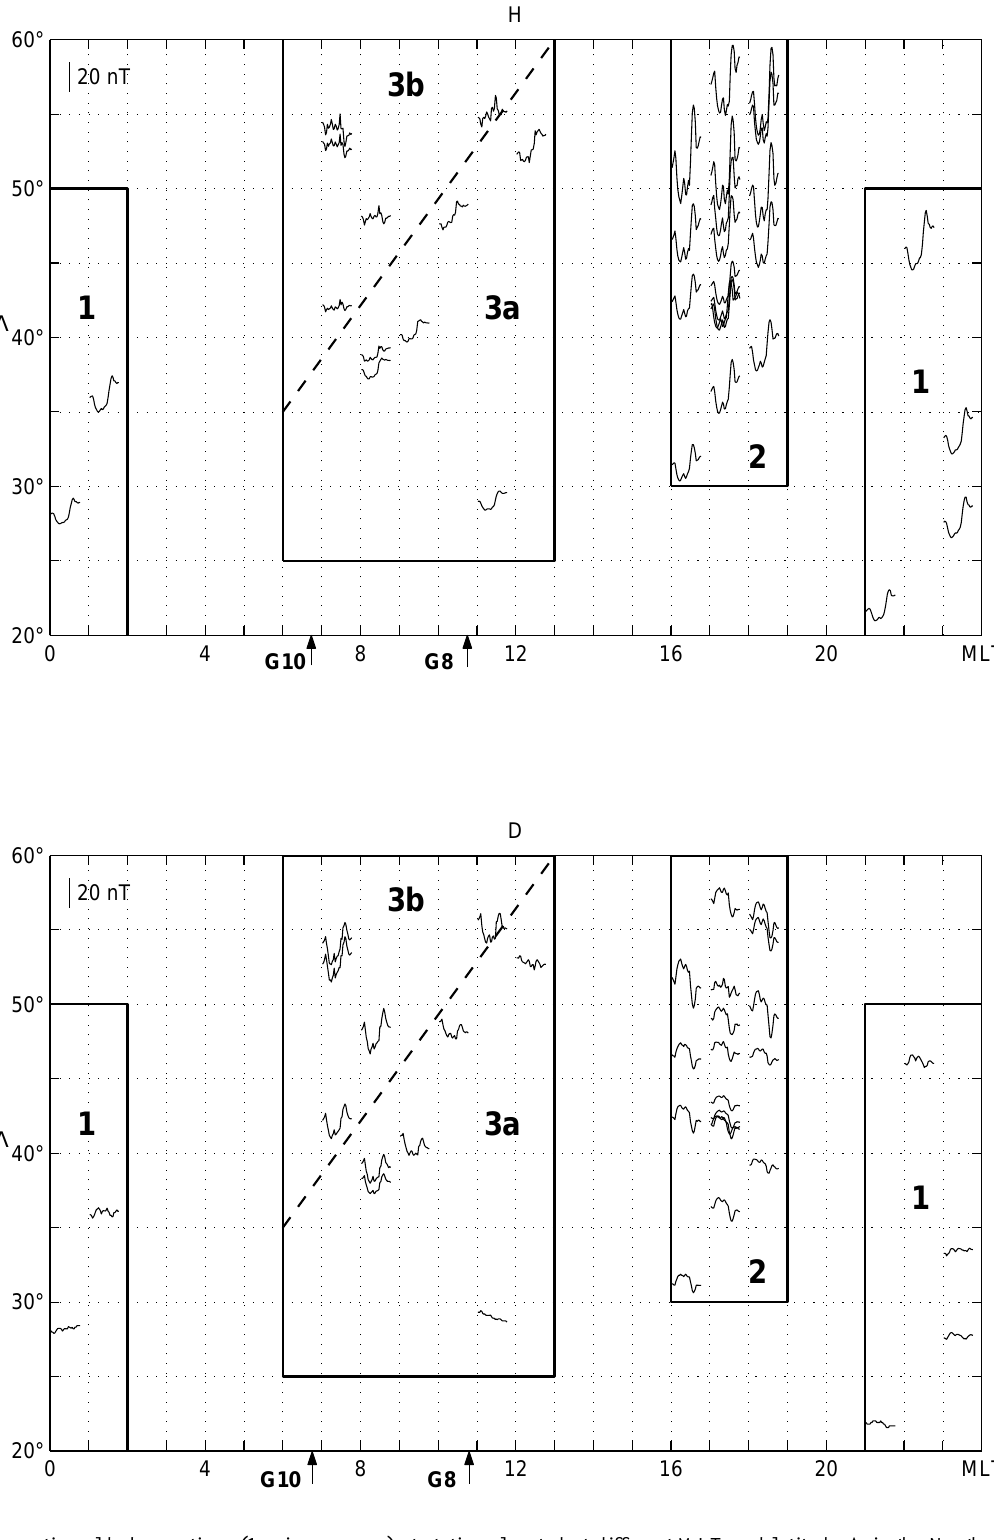
Fig. 2. Geomagnetic field observations (1-min averages) at stations located at different MLT and latitude 3 in the Northern Hemisphere for the time interval 15:35–16:05 UT. H component is in the upper panel and D component in the lower panel. Ground observations are organized in four groups, 1, 2, 3a, and 3b, according to the similar behavior observed in the geomagnetic field components. The MLT of GOES satellites (G8 and G10) is marked with arrows at the bottom of both